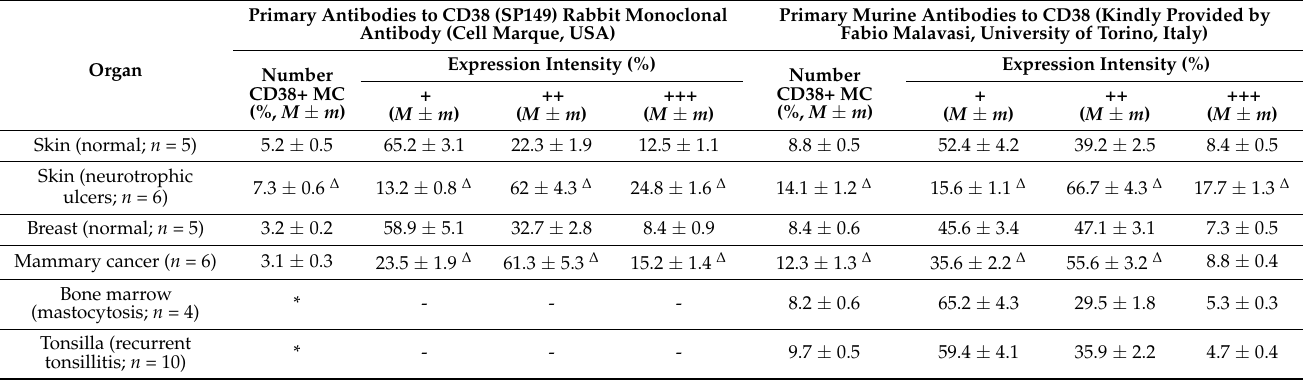
Table 3. Efficiency of immunomorphological detection of CD38 in